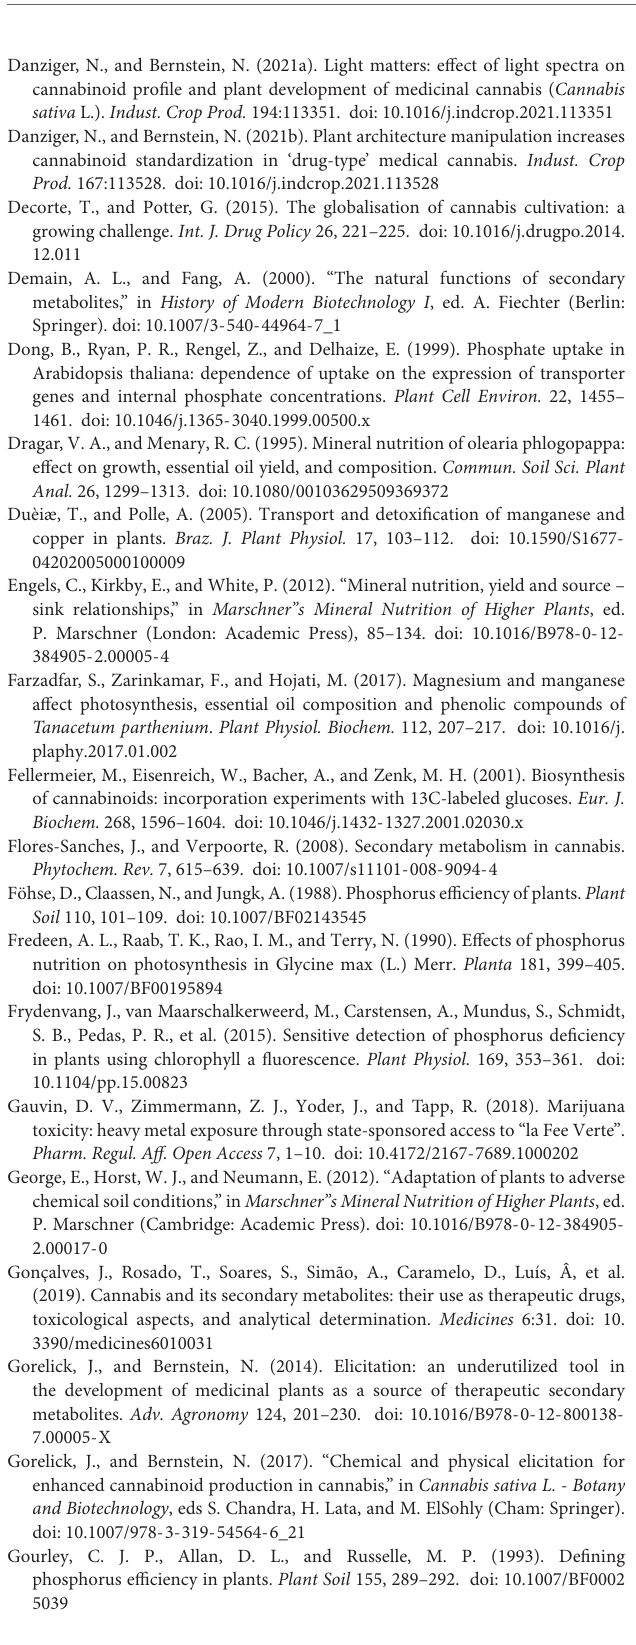
Frontiers in Plant Science |